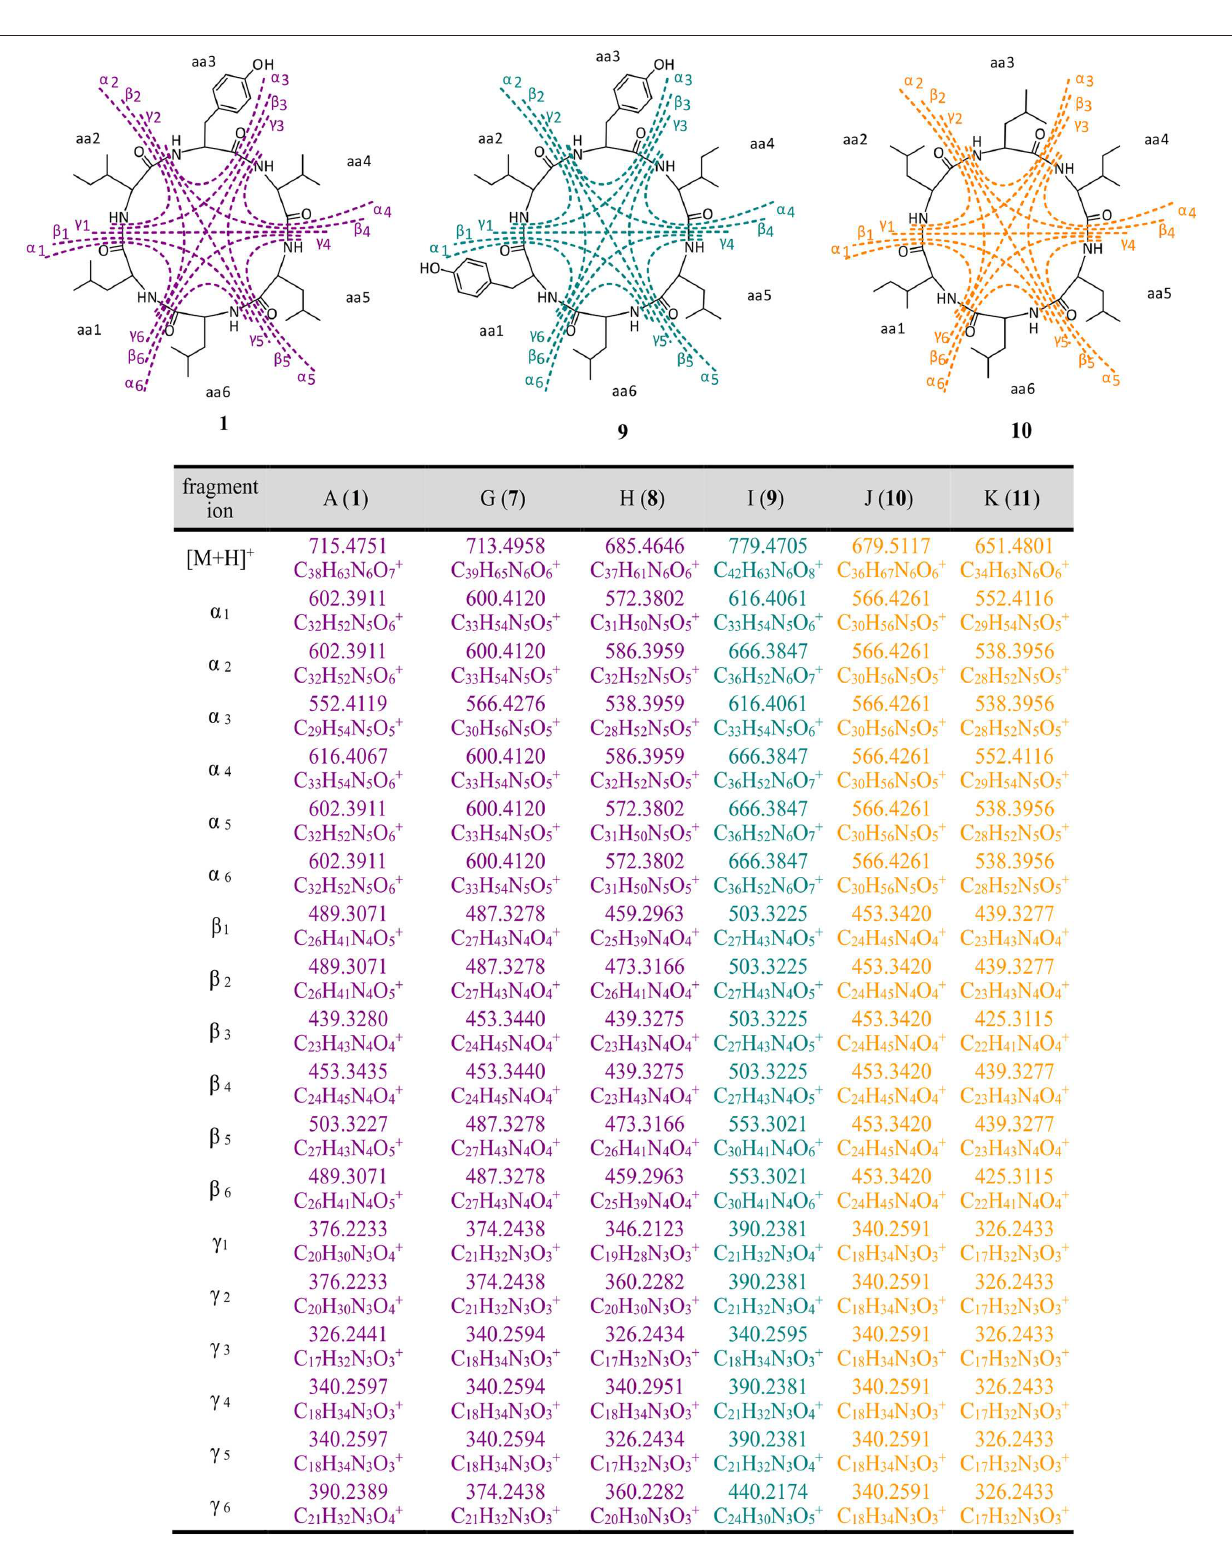
Frontiers in Chemistry |